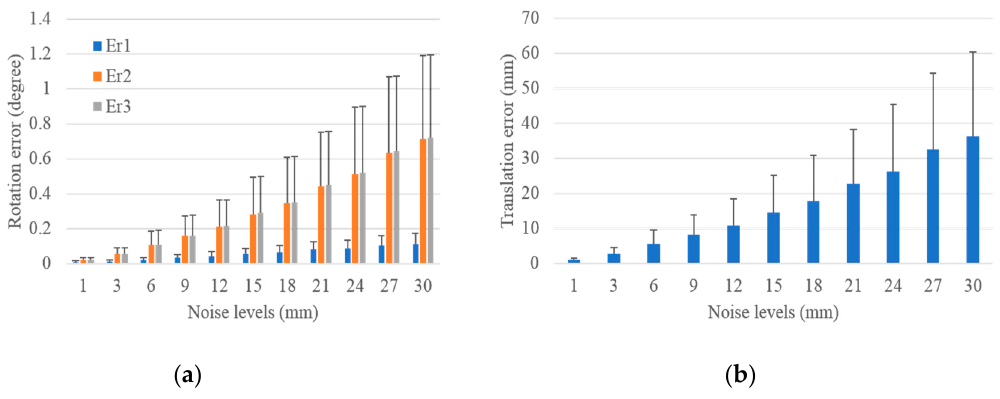
Figure 11. Rotation and translation errors for the extrinsic calibration of LRF with respect to the camera